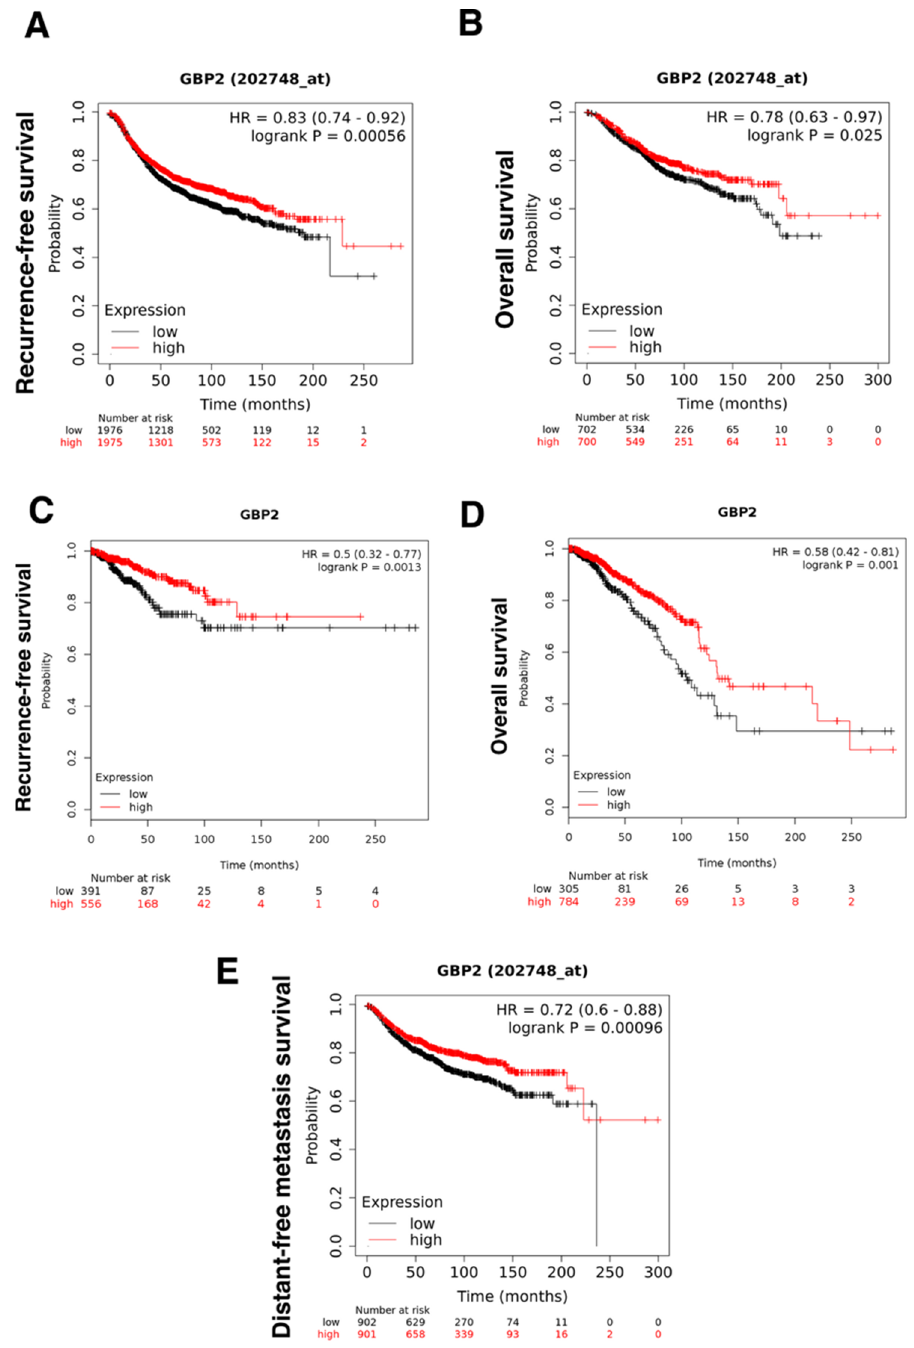
Figure 1. GBP-2 correlates with better recurrence-free (RFS), overall survival (OS), and distance metastasis-free survival (DMFS) in human breast cancers. ( A ) The probability of RFS versus time for breast cancers of all types, stages, and grades was plotted for those tumors with high and low levels of GBP-2 expression. ( B ) The OS of patients of patients with all subtypes, stages, and grades was plotted for those tumors with high versus low GBP-2 expression versus time. ( C ) RNA seq data was used to confirm the array data for GBP-2 and RFS. ( D ) RNA seq data was used to confirm the array data for GBP-2 and OS. ( E ) The correlation between GBP-2 expression and DMSF was